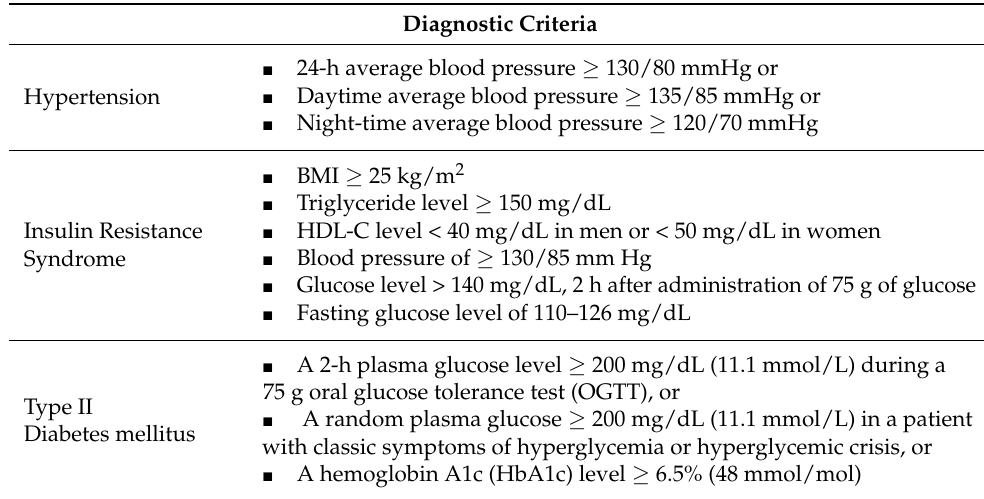
Table 2. Diagnostic Criteria for